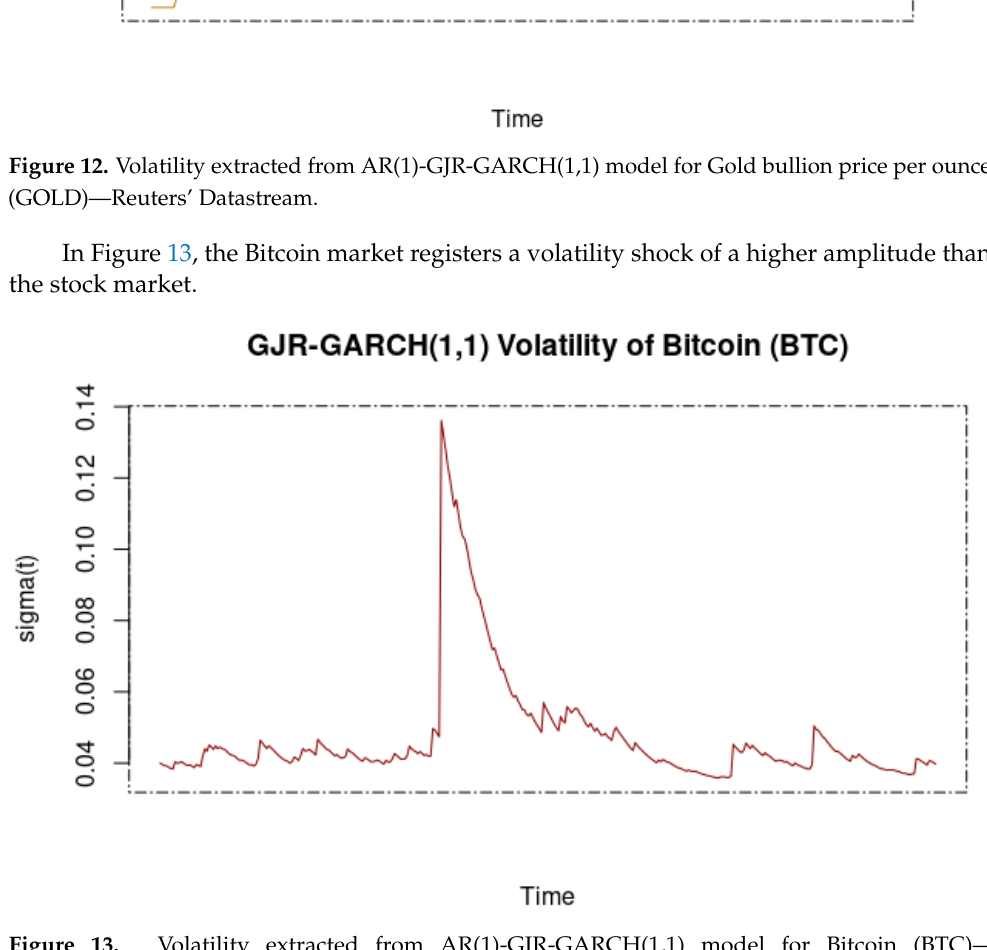
Figure 13. Volatility extracted from AR(1)-GJR-GARCH(1,1) model for Bitcoin (BTC)—